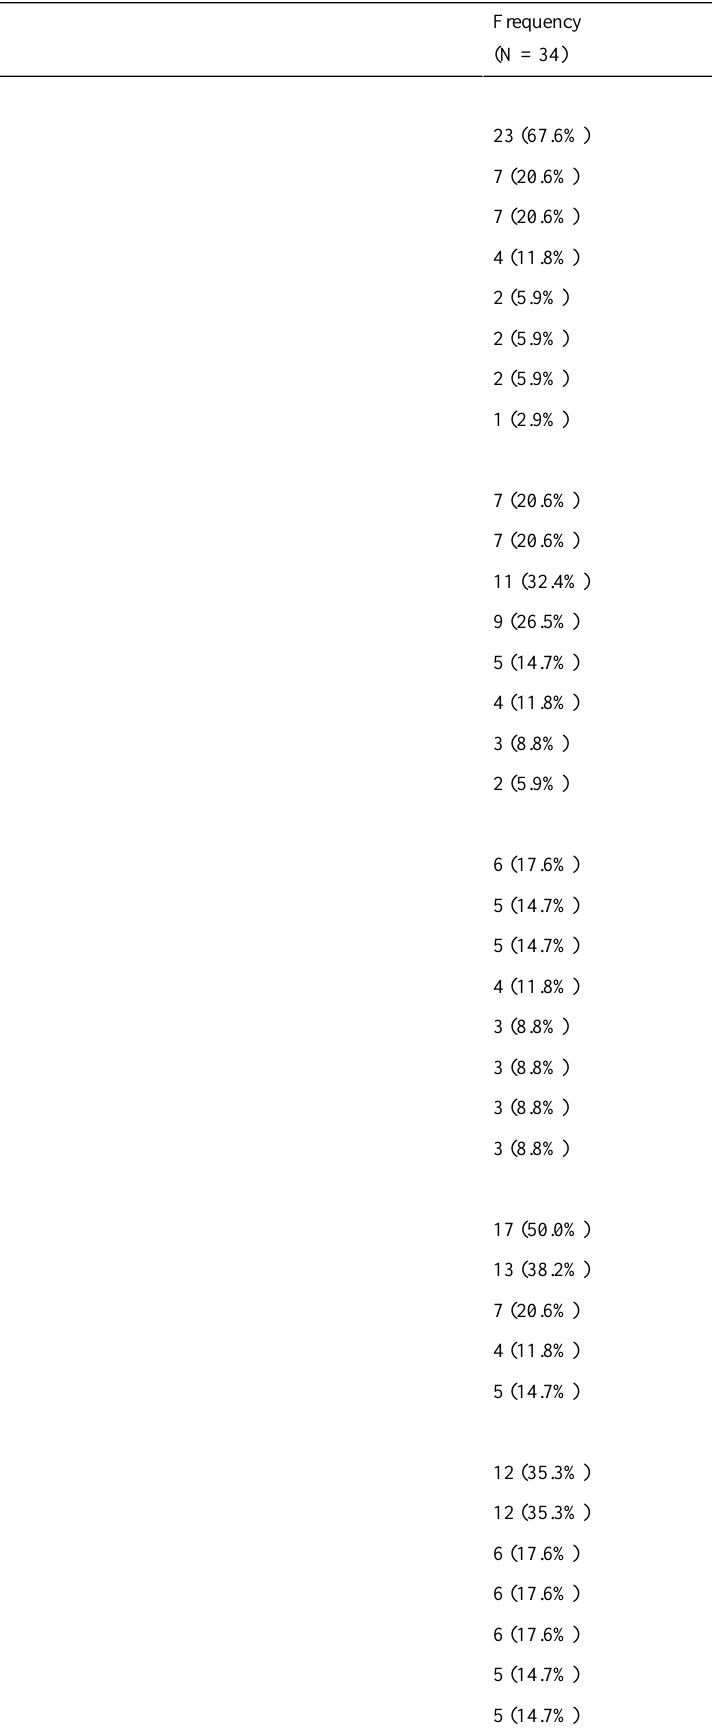
Table 3. Smoking decision balance (patients could mention as many benefits or negative consequences as they